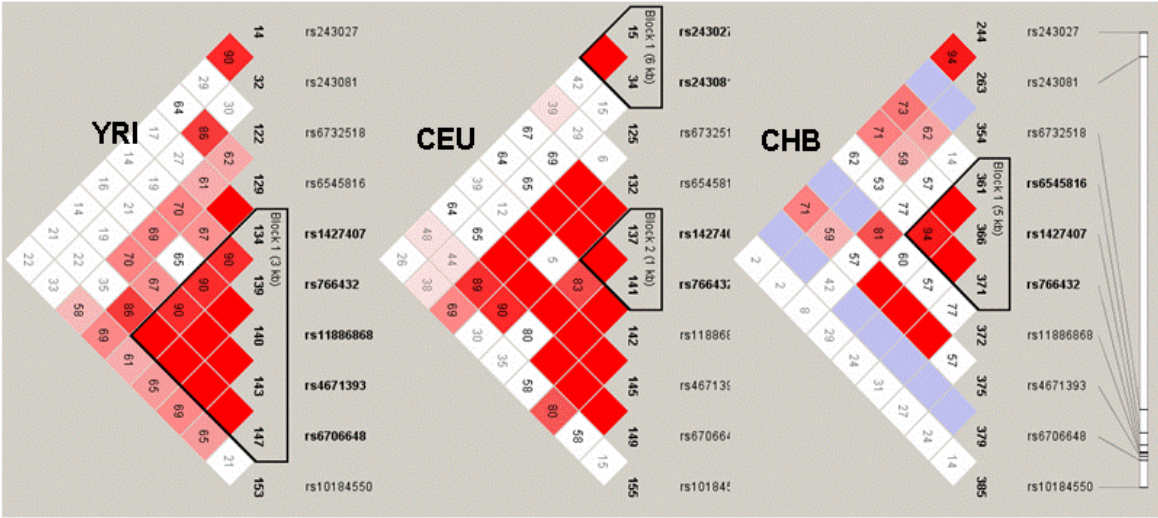
FIGURE 2. LD plots incorporating SNPs of BCL11A. Each square reports the value of D’, with the standard LD color scheme: white D’ < 1 and LOD < 2; blue D’ = 1 and LOD < 2; shades of pink/red D’ < 1 and LOD ≥ 2; bright red D’ = 1 and LOD ≥ 2. YRI, trios from Ibadan, Nigeria; CEU, trios from Utah residents with northern and western European ancestry; CHB, Han Chinese from Beijing, China. Generated using HapMap data with the program HaploView 4.0. (From Sedgewick et